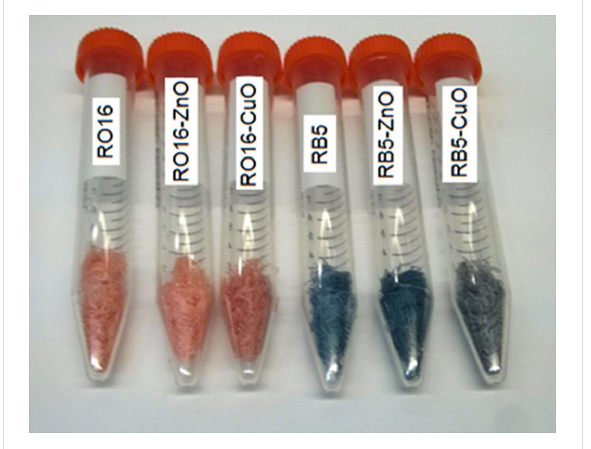
Figure 2: Images of textile fibers (shredded bandages) colored with RO16 and RB5 dyes and functionalized with ZnO and CuO NPs in a one-step sonochemical